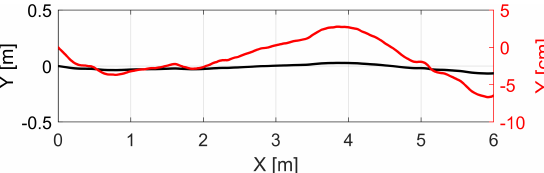
Figure 3. Top view of the measured trajectory obtained by the laser tracker. Two visualizations of the same trajectory in order to highlight the almost linear course. The black curve is regarding the left y-axis (meter) and the red curve regarding the right y-axis